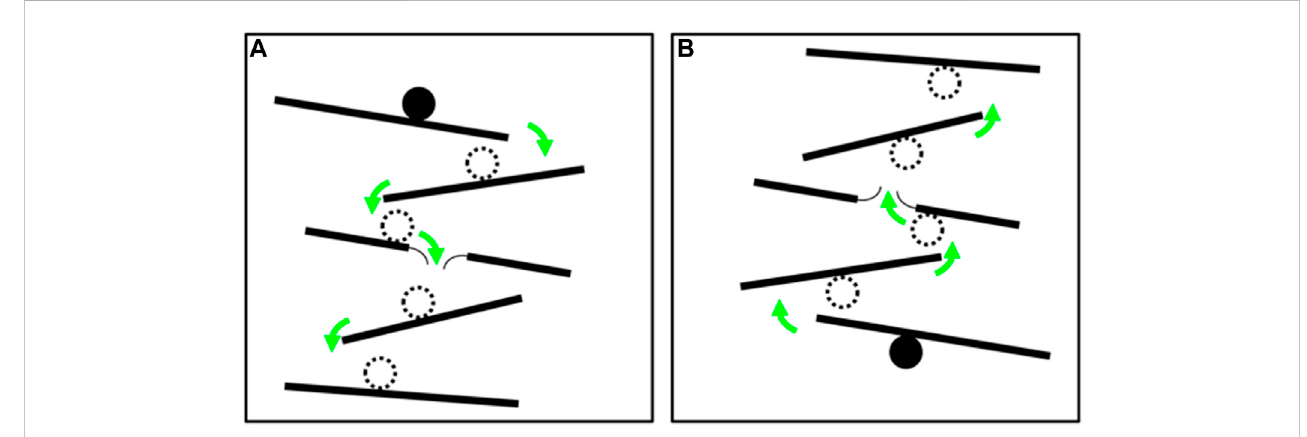
FIGURE 9 Schematic illustration of a hypothetical marble run. Green arrows show the path the marble will take when placed on the top ramp. (A) . Right-side up. A thin paper membrane on the third ramp represents a potential leak point if the marble weighs more than the membrane can hold. (B) . Upside-down marble run representing the concept of trap analysis for a buoyant fl uid, such as petroleum or CO 2 .